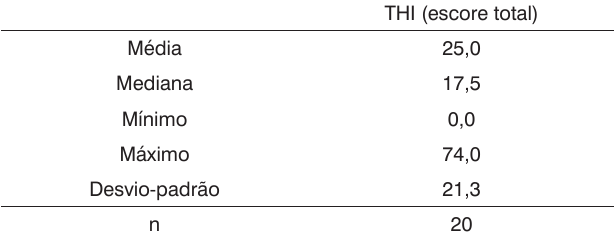
Tabela 2. Medidas descritivas do Tinnitus Handicap Inventory